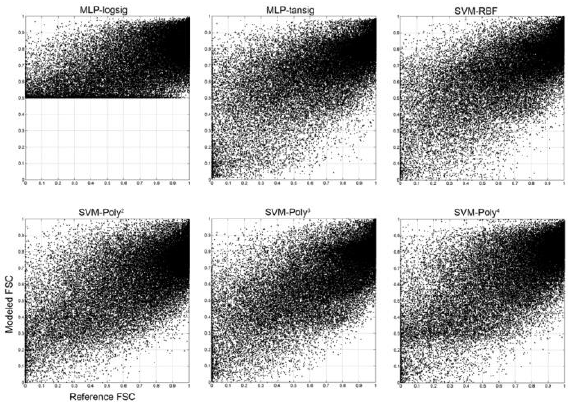
Figure 7: Landsat-derived reference FSC values vs. estimated FSC values by ANN and SVM models.